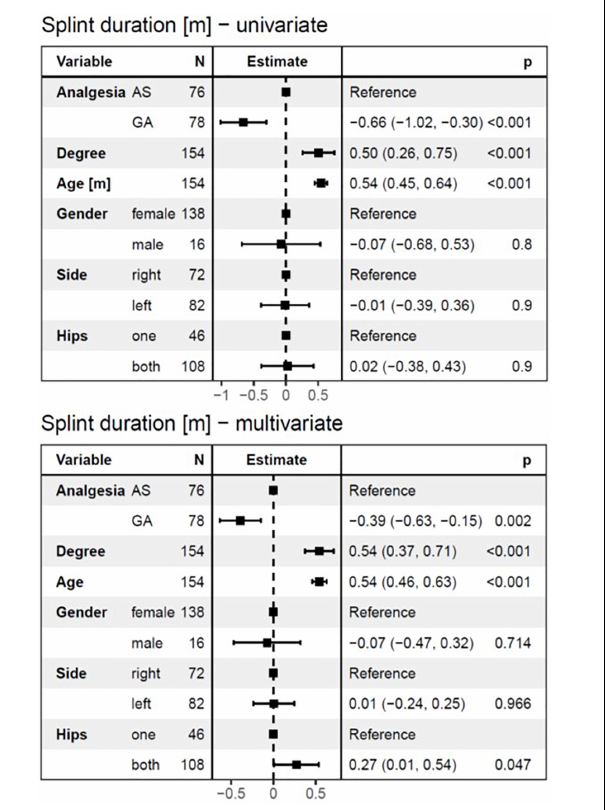
FIGURE 6 | The linear regression model for splint duration as a dependent variable. Both univariate and multivariate analyses showed a highly significant influence of age at diagnosis and the degree of DDH on the splint duration. Furthermore, splint duration was –0.66 months (95% CI : –1.03 to –0.3, p < 0.001) shorter in the GA group than in the AS group in the univariate analysis, and –0.39 months (95%CI: –0.63 to –0.15, p = 0.002) in multivariate analysis. Interestingly, affection of both hips by DDH led to a 0.27 months longer splint duration (95%CI:0.01–0.54, p < 0.05) in the multivariate analysis. AS, analgesia and sedation; GA, general anesthesia; N, number of affected hips.